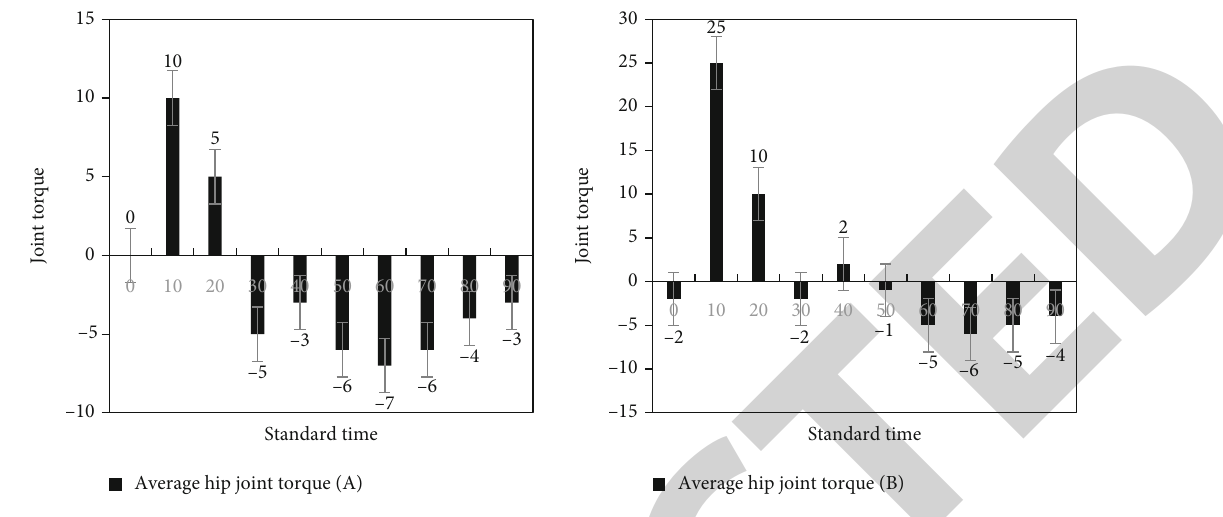
Figure 7: Comparison diagram of hip joint muscle torque.